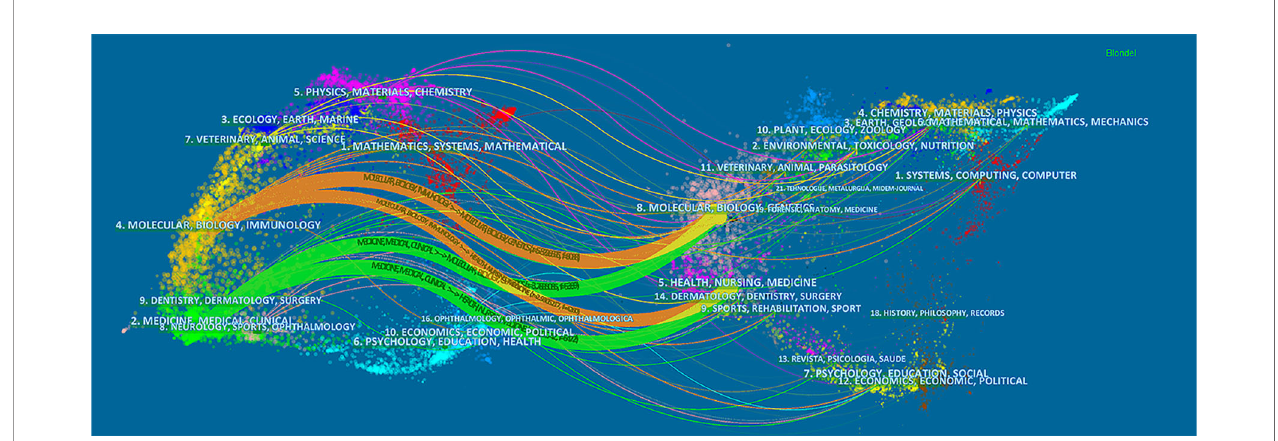
FIGURE 5 | The dual-map overlay of journals related to drug-induced liver injury (DILI) research.